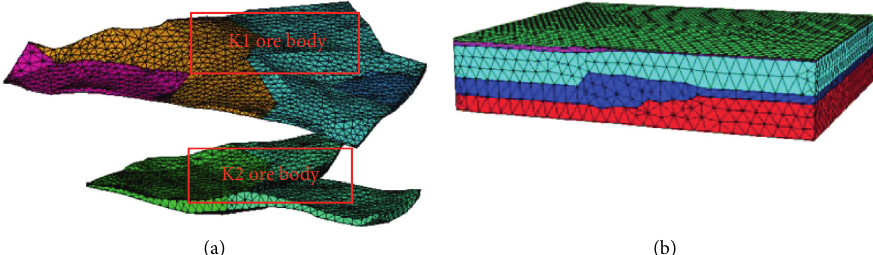
Figure 7: Three-dimensional model of the ore body and the surrounding rock three-dimensional model. (a) Ore body of K1 and K2. (b) Three-dimensional model.